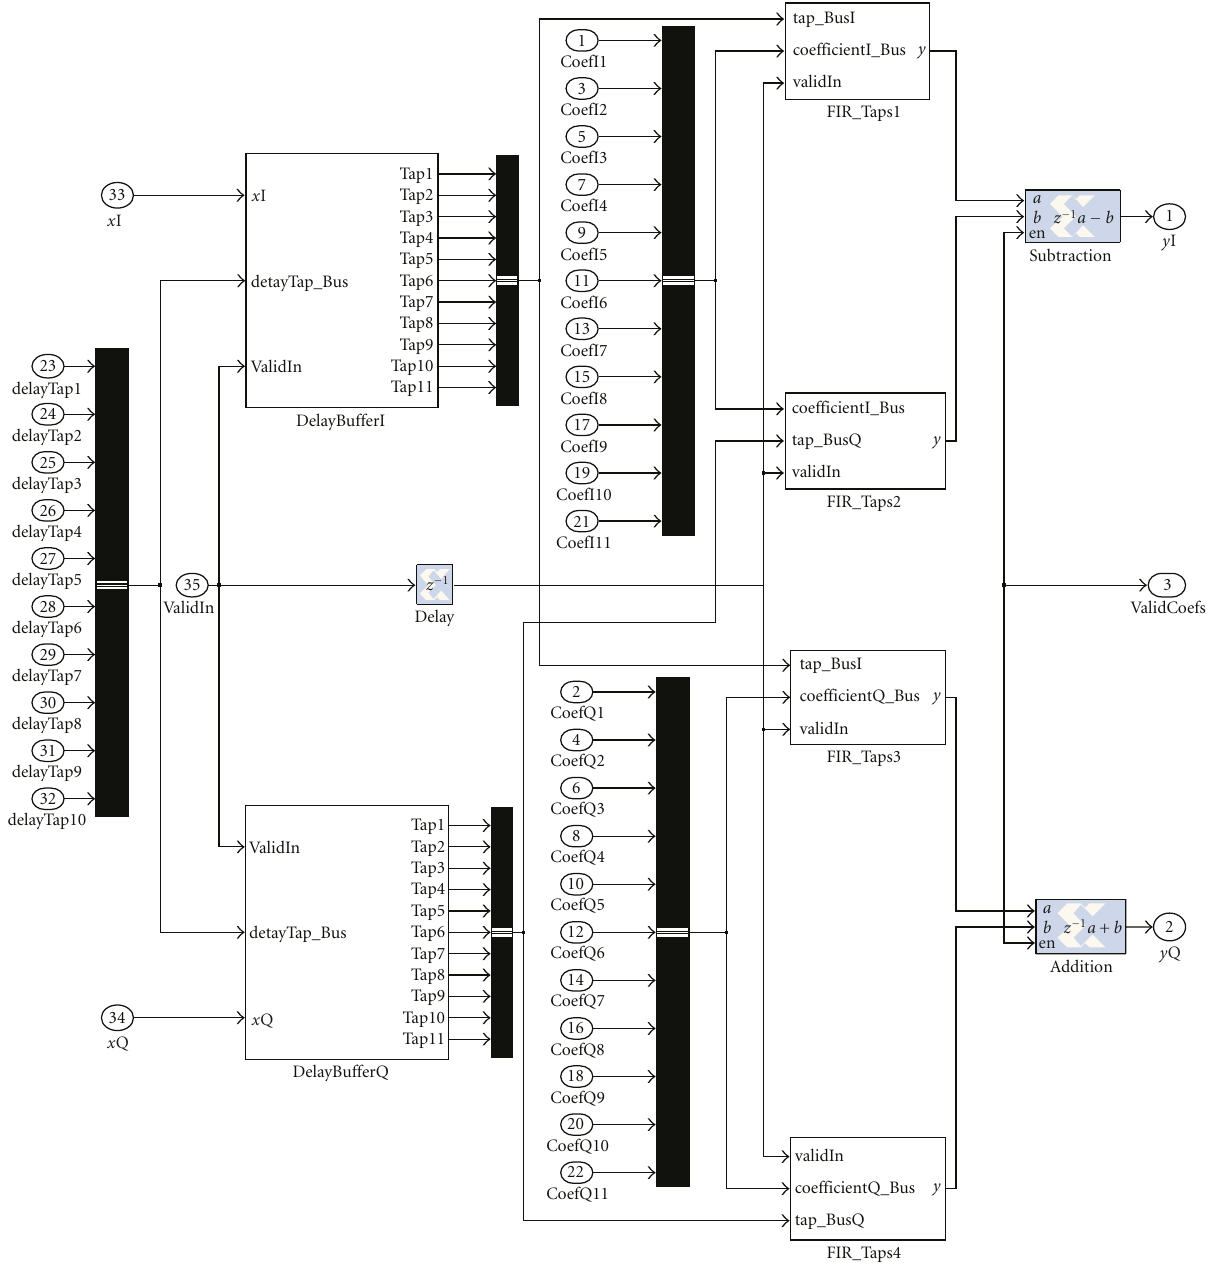
Figure 7: General view of the complex FIR